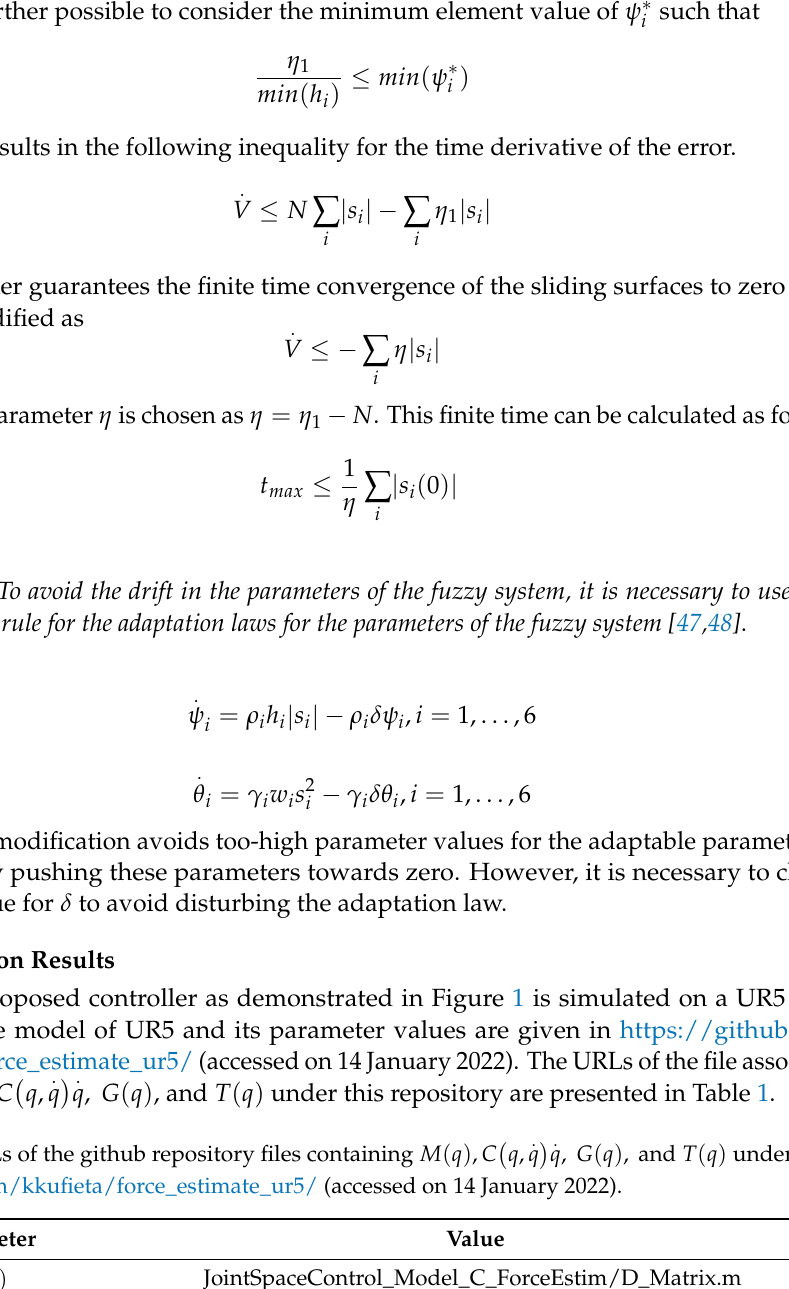
Table 1. URLs of the github repository files containing M ( q ) , C